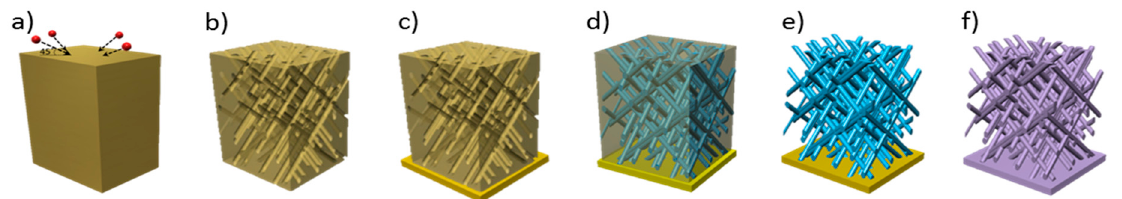
Figure 1. Schematic view of the different steps applied for nanowire synthesis: ( a ) Irradiation of polycarbonate films with heavy ions of GeV kinetic energy. The irradiation is performed in sequential steps from different angles of beam incidence; ( b ) chemical etching in 6M sodium hydroxide (NaOH) at 50 °C converts the ion-tracks into open nanochannels; ( c ) gold sputtering followed by electrochemical deposition provides a stable gold back-electrode; ( d ) electrodeposition of zinc oxide (ZnO) inside the membrane channels; ( e ) release of the ZnO networks by dissolution of the polymer template; ( f ) atomic layer deposition (ALD) of a titanium dioxide (TiO 2 ) thin film conformally coating the wires and the gold substrate.